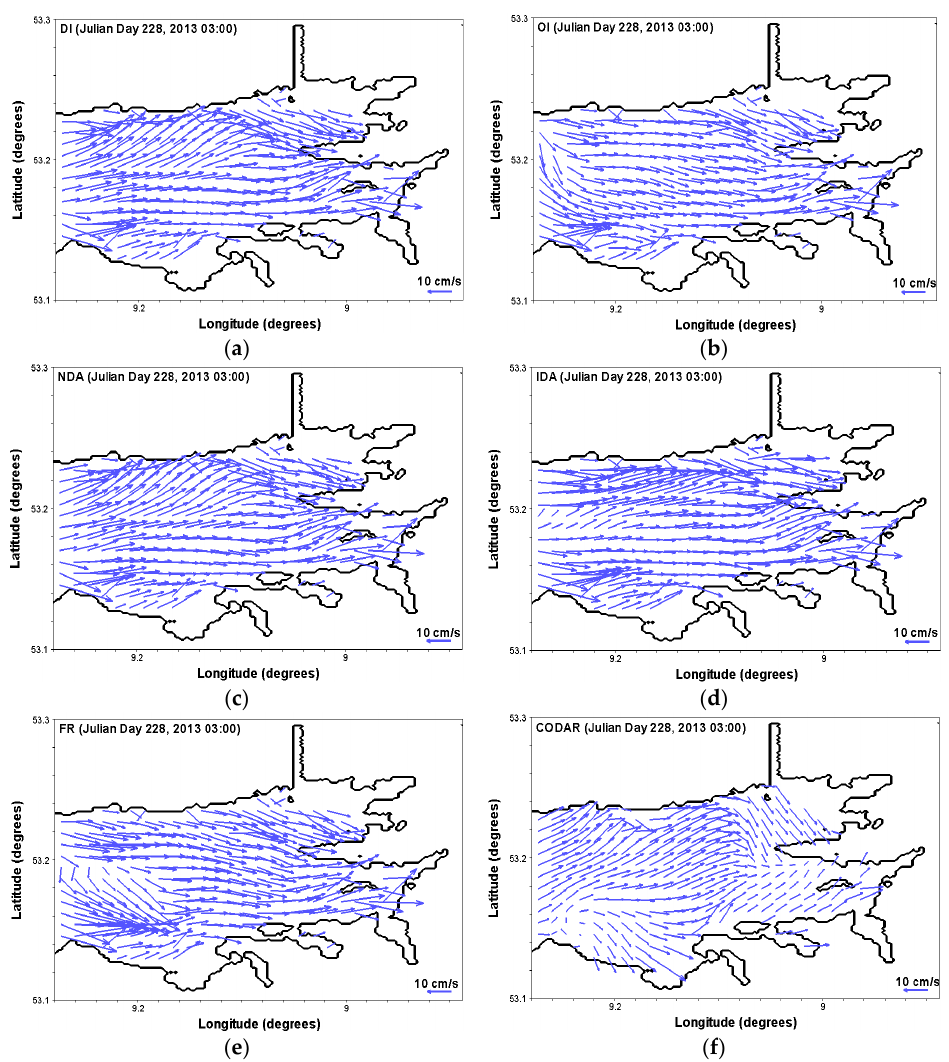
Figure 6. Vector fields of surface currents at Julian Day 228 03:00: ( a – d ) model DI, OI, NDA and IDA, respectively; ( e ) model FR; and ( f ) HFR data.